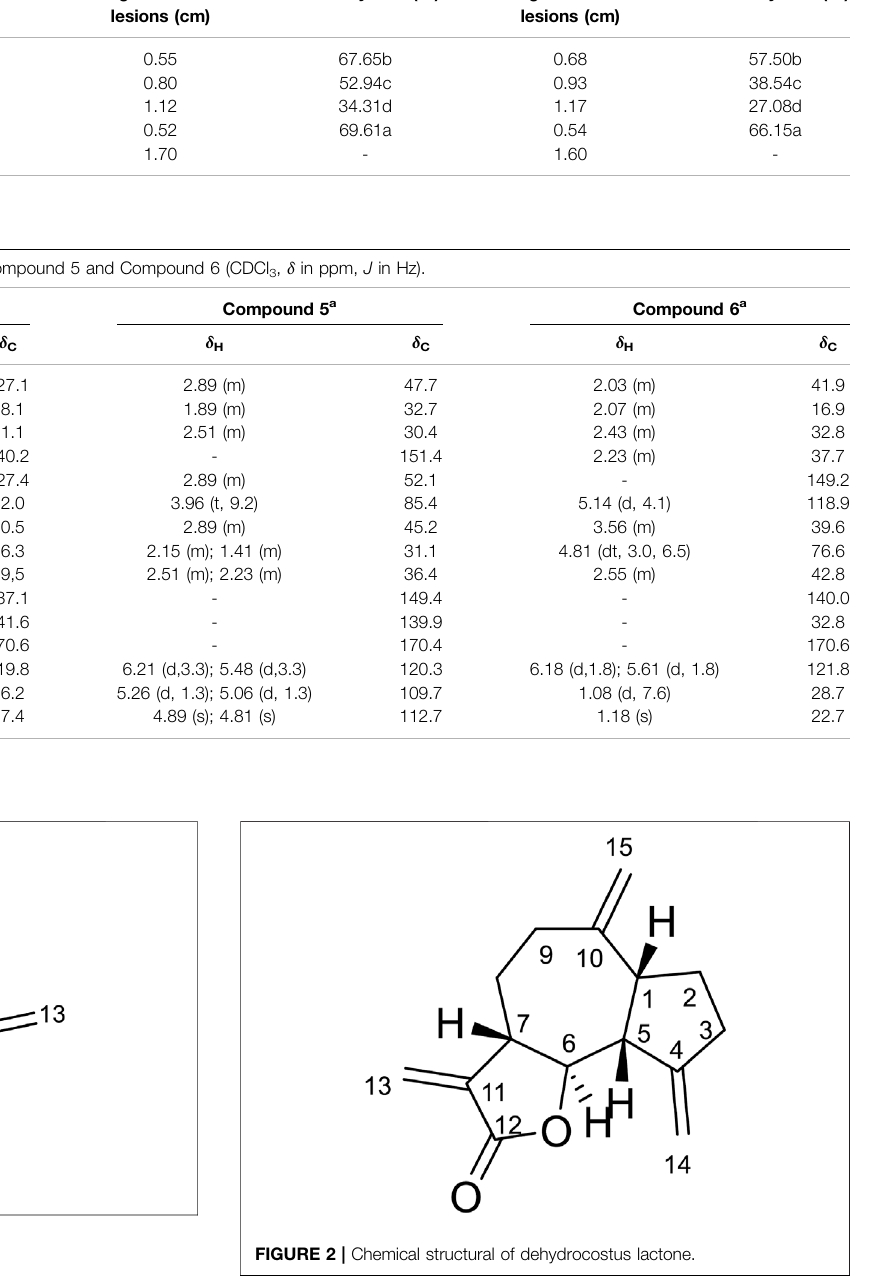
oxy-methine carbon ( δ C 81.9), one methine carbon ( δ C 50.3), four methylenes ( δ C 40.9, 39.4, 28.0, 26.1), and two methyl carbons ( δ c 17.3, 16.0). These spectral data were elucidated to the published data of Costunolide (Kaur et al., 2017; Chacon- Morales et al., 2020). Therefore, compound 2 was identi fi ed as costunolide and its molecular formula is shown in Figure 1 . MS diagrams and 1 H-NMR and 13 C-NMR spectra were shown in Figures S1, S2 and S3, respectively.